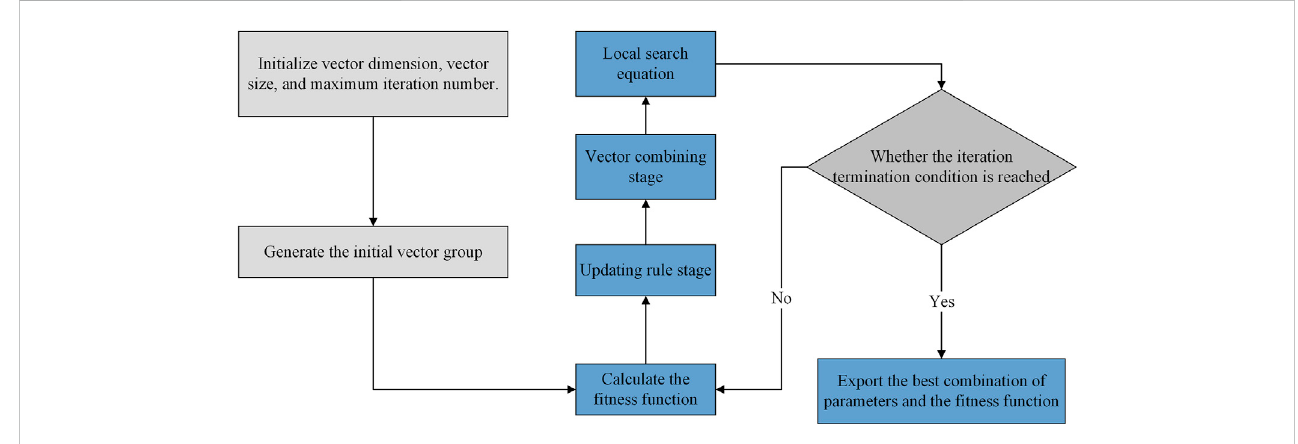
FIGURE 1 Flow chart of the INFO